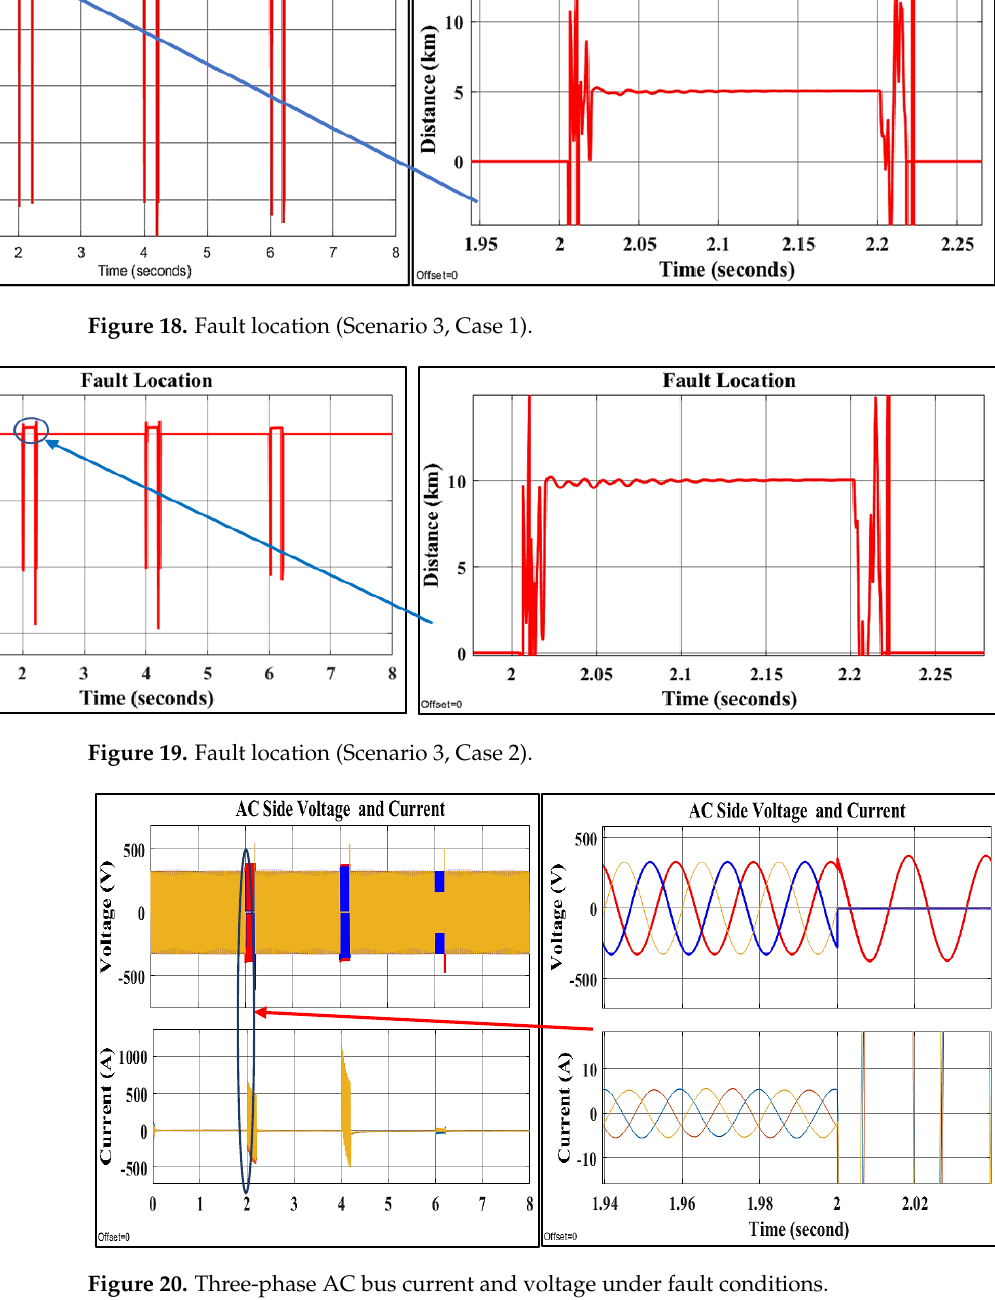
Figure 21. AC bus frequency under faults occur . Figure 22. AC bus current and fault detection signal .